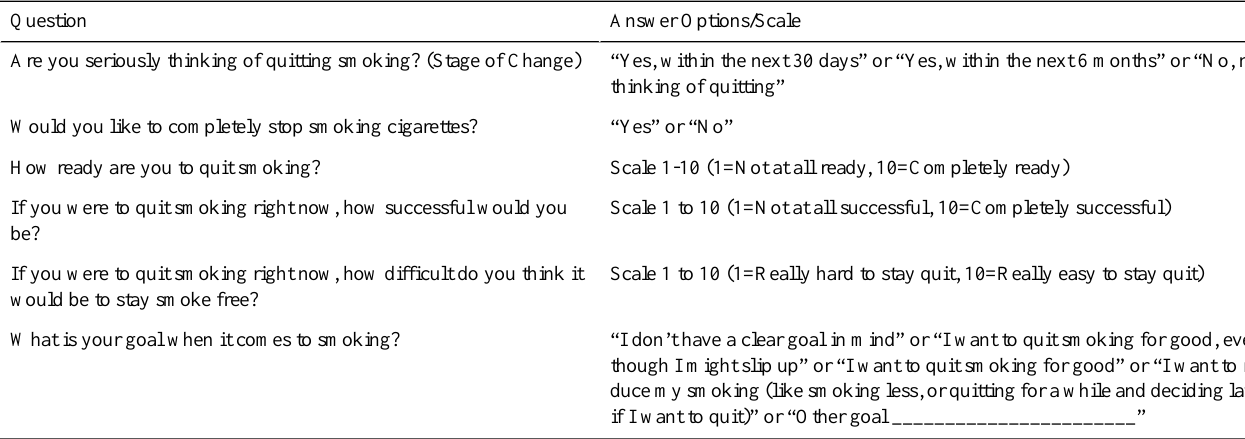
Table 2. Measures assessing attitudes toward quitting